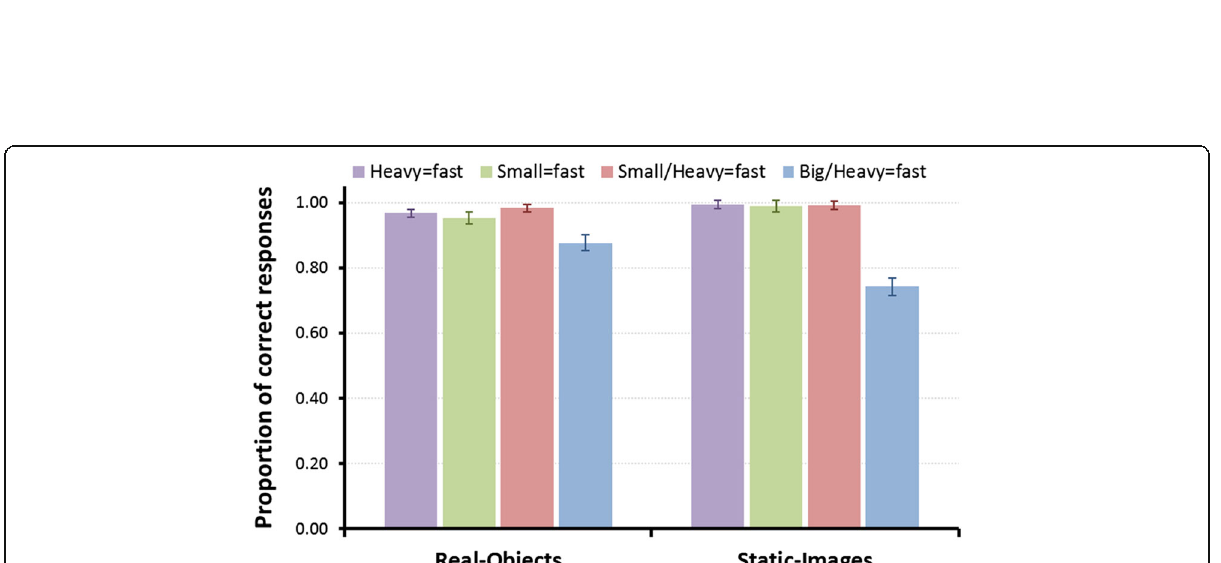
Fig. 6 Average proportion of correct answers in Experiment 2, separated by condition and trial type (see Fig. 1 for an example of each trial type). Trials differ in whether the faster object in a pair was heavy (heavy = fast), small (small = fast), small and heavy (small/heavy = fast), or big and heavy (big/heavy = fast). A mixed-design condition-by-trial analysis of variance (ANOVA) revealed a main effect of trial type. Specifically, we found worse performance on big/heavy= fast trials ( M = .88) than on all other trials ( M s > .97), F (3,153) = 62.54, p < .001, η 2 = 0.55, 1- β = .99. There was also a significant condition-by-trial interaction, F (3,153)=13.87, p <.001, η 2 =0.21, 1- β =.99: In the static-images condition, only performance on big/ heavy = fast trials ( M = .74) was lower than all other trials ( M s = .99). In contrast, in the real-objects condition, performance on both big/ heavy = fast trials ( M = .88) and small = fast trials ( M = .95) was lower than the performance on all other trials ( M s = .99). No other effects were significant, F (3, 153) < 0.86; p >